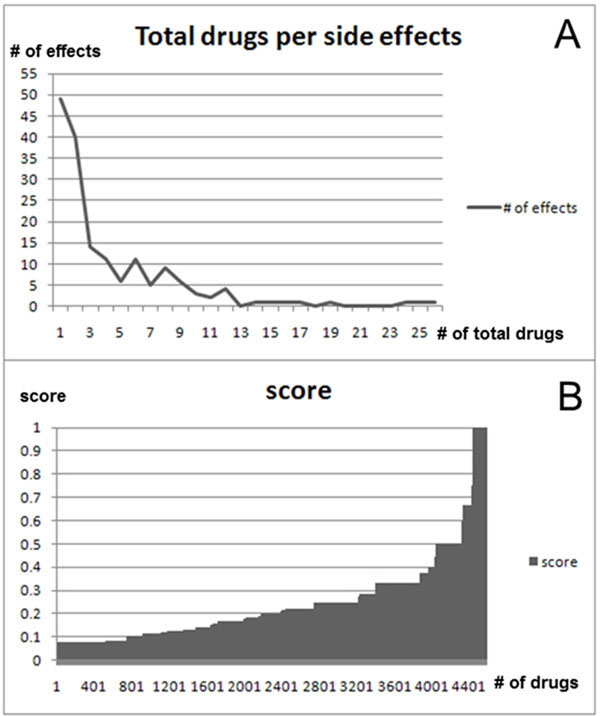
Network statistics in drug upregulated biological process-side effect network. Figure 6A shows the relationship between side effects and the total number of connected drugs in upregulated processes. The range of the total number of drugs is 1 to 26. It shows that 49 side effects occurred with only 1 drug, and 26 drugs caused nausea. Figure 6B shows that most scores of relations (about 88%) are less than 0.5. Half of relation scores are less than 0.2. Further, only 543 relation scores are greater than or equal to 0.5. This means that many significant processes are not over-represented among drugs. Therefore, a threshold needs to be determined to show which processes are highly related to which side effect (Table 2)